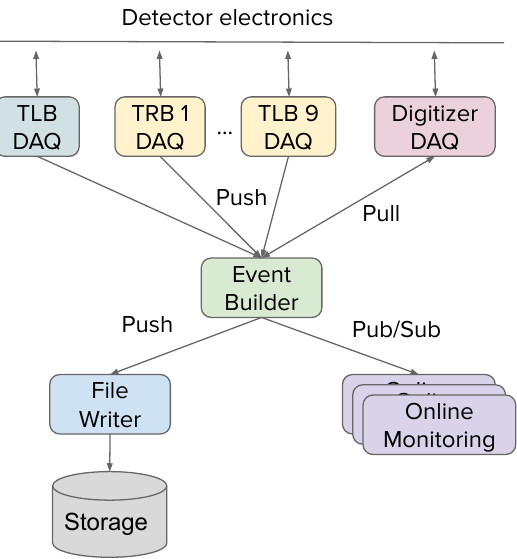
Figure 3. Overview of the FASER DAQ